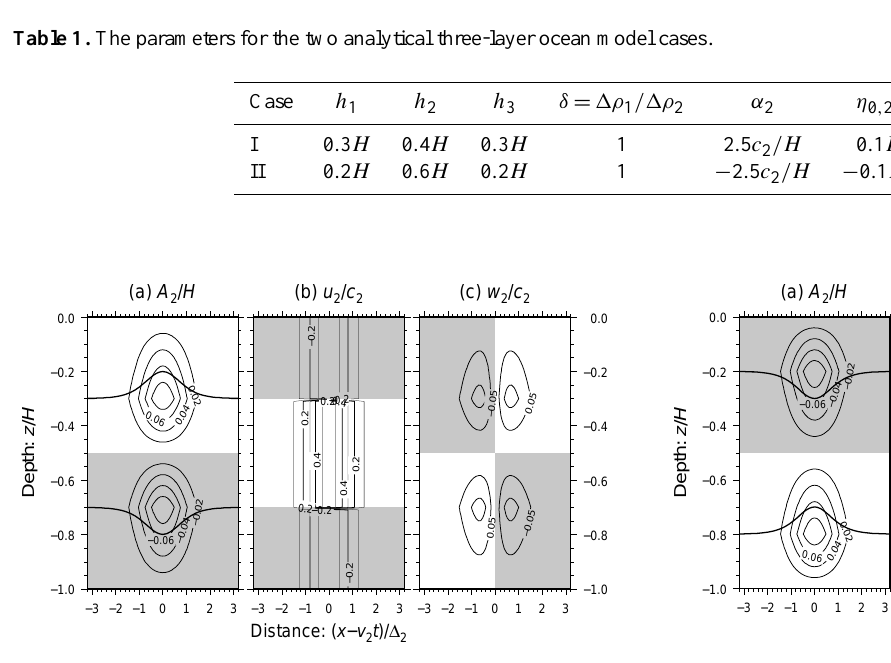
Fig. 7. Same as Fig. 6, except for a concave mode-2